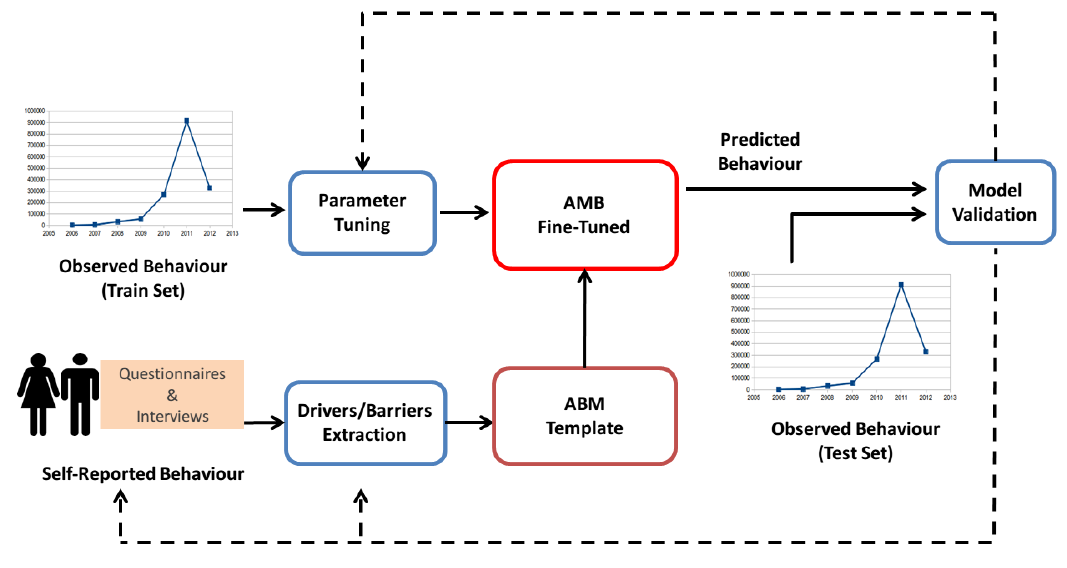
Figure 1. Methodology